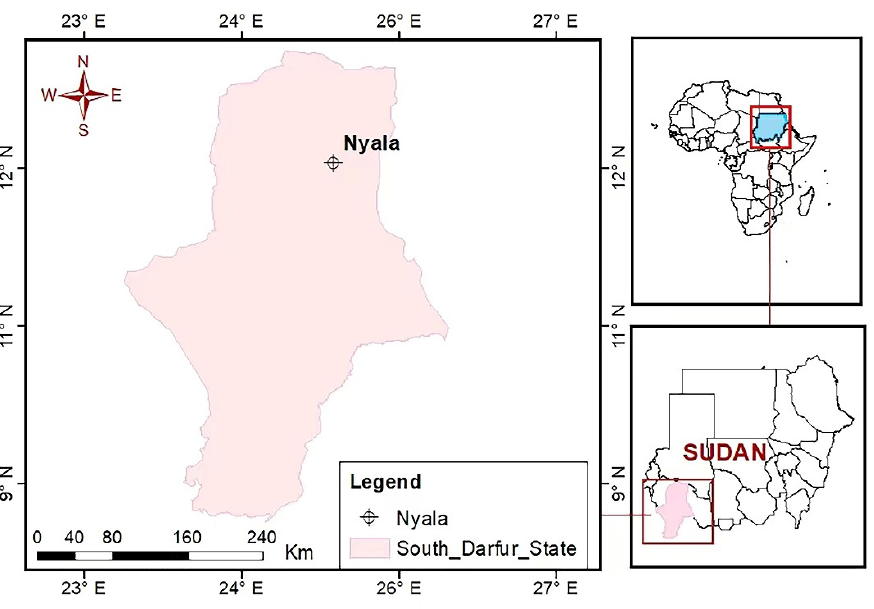
Figure 1. Locations of Nyala City in South Darfur, Sudan.